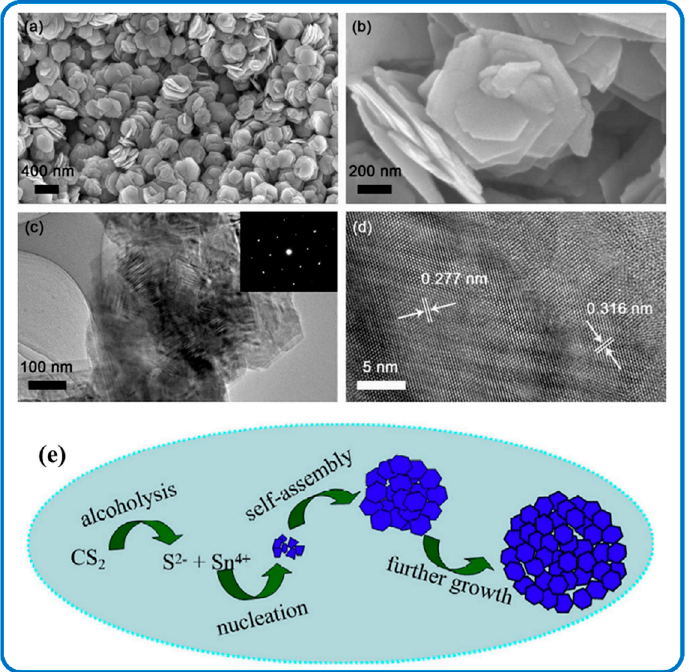
Figure 7. ( a , b ) SEM, ( c ) TEM images, and ( d ) Fringe interval of the as-prepared SnS 2 nanoflowers. Reproduced with permission from [128]. Copyright 2018, Elsevier. ( e ) Schematic illustration of 3D SnS 2 nanoflowers. Reproduced with permission from [129]. Copyright 2013, Elsevier.